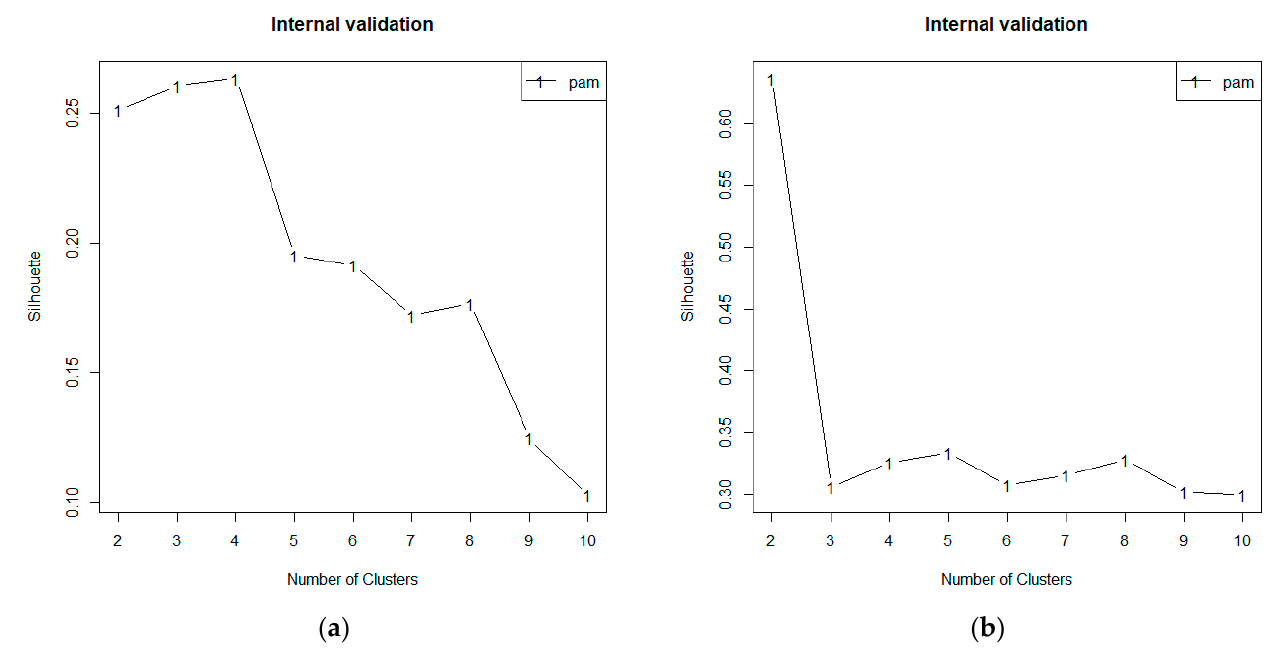
Figure 3. Silhouette width plot for each number clusters: ( a ) Clustering period 1 July 2021–30 September 2021, ( b ) clustering period 1 January 2022–31 May 2022.